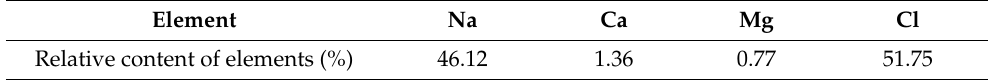
Table 5. Crystal composition